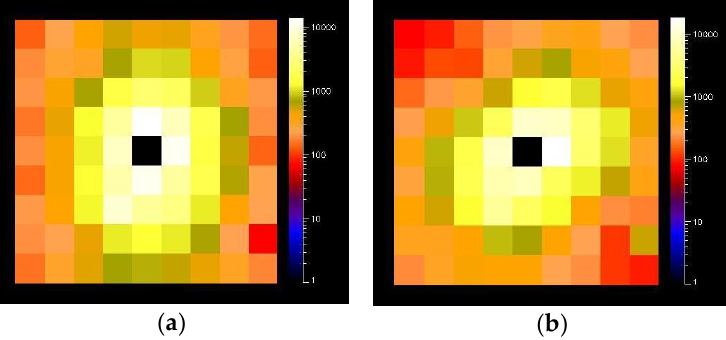
Figure 4. False color scattering maps obtained with the IMARAD-PolCA detector using a 511 keV beam at ESRF (ID15A) with two different orientation angle ( φ 0 ) of the polarization plane with respect to the detector side axis: ( a ) φ 0 = 0 ◦ ; ( b ) φ 0 = 45 ◦ . The photon beam was collimated at 0.5 × 0.5 mm 2 in the center of the central pixel, orthogonally to the detector plane. The central map cell is set black because represent only the reference point of each Compton scattered event and in the ESRF irradiation condition coincide with the impinging pixel.